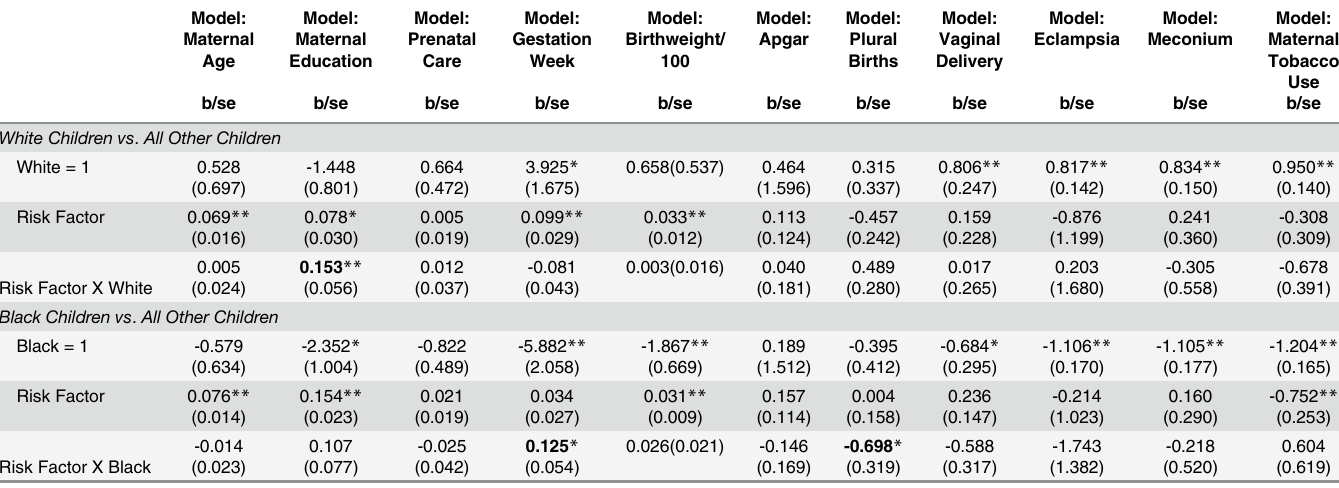
Table 3. OLS Regression of Self-regulation on Risk Factors X Race Interactions ( n (cid:1)